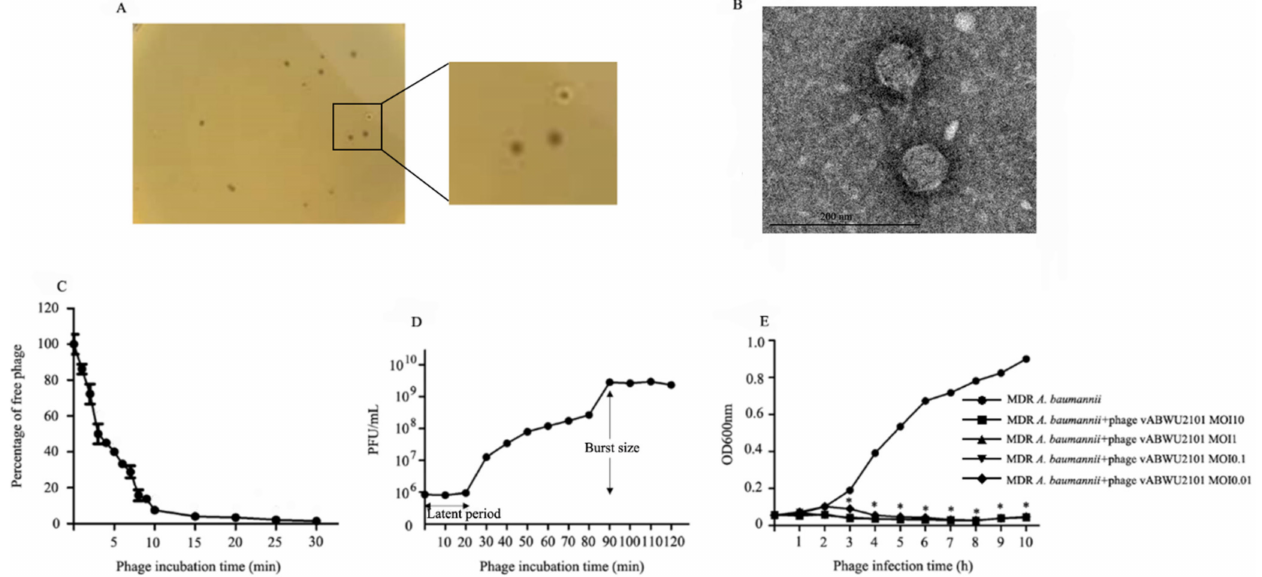
Figure 1. Isolation, morphology, and biological properties of phage vABWU2101. ( A ) Plaque morphology of phage vABWU2101; ( B ) transmission electron micrograph of vABWU2101. Scale bar indicates 200nm. ( C ) Adsorption rate of phage vABWU2101 to host bacterial strain. ( D ) One-step growth curve of phage vABWU2101 to host bacterial strain. The latent period and burst size of phage vABWU2101 were estimated. ( E ) In vitro planktonic cell lysis assay of phage vABWU2101 at different MOIs against host bacterial strain. Experiments were undertaken independently in duplicate with duplicate assay. The data show the mean ± SD (* p value <